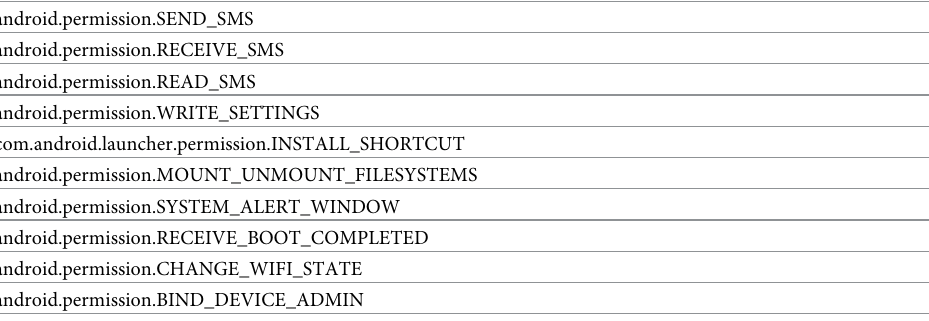
Table 5. The top ten permissions of the frequency similarity weight